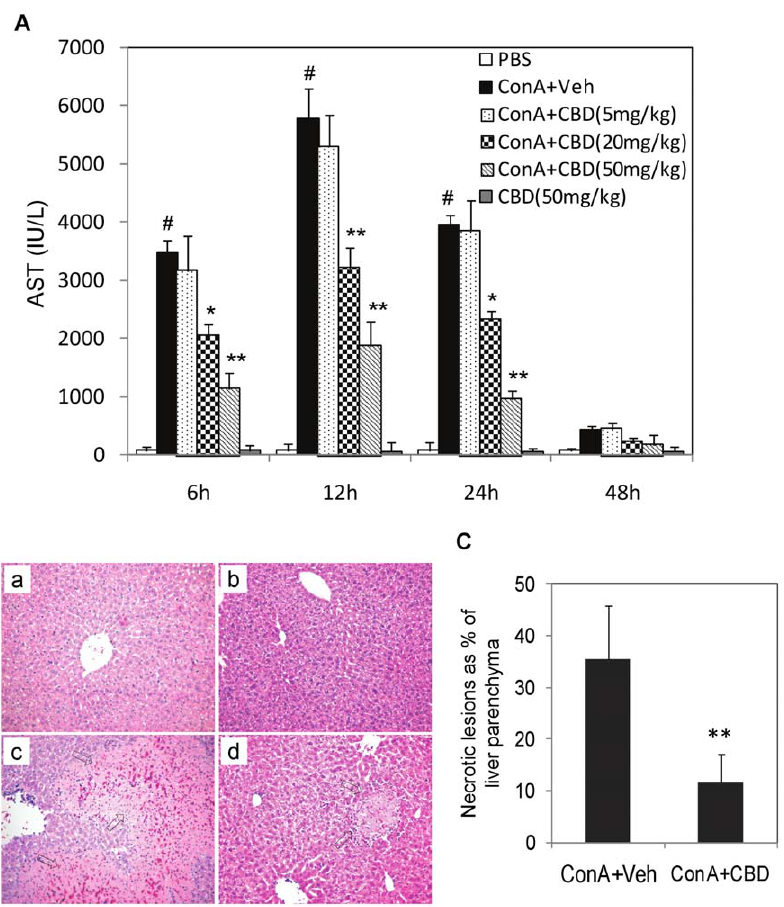
Figure 1. Cannabidiol (CBD) attenuates ConA-induced hepatitis in mice. WT mice (n=6) were injected with PBS (control), or ConA (12.5 mg/ kg bd.wt., i.v. ) to induce hepatitis. ConA injected mice were administered i.p. with vehicle or CBD at 5, 20 or 50 mg/kg bd.wt. CBD group received CBD alone at 50 mg/kg. A) Blood was collected at 6, 12, 24 and 48 h and serum aspartate transaminase (AST) was determined by spectrophotometric assay. Data represent mean 6 SEM from 6 individual mice. The changes in AST levels were analyzed by Student’s t -test ( # p , 0.01 compared to PBS; *p , 0.05, **p , 0.01 compared to ConA + veh). Histological analysis: B. Representative H&E stained liver sections obtained 24 h post ConA injection in WT mice (original magnification 6 100). a) Vehicle and b) CBD alone, show normal tissue morphology; c) ConA + veh shows large necrotic lesion induced by ConA (arrows); d) ConA + CBD (50 mg/kg bd.wt.) shows less necrosis (arrows) of liver parenchyma. C) Quantification of necrotic lesions as a percentage of liver parenchyma. Data are mean 6 SEM from 4 mice per treatment. At least five fields were analyzed per section from each liver sample. PBS and CBD controls did not show any necrotic lesions. Student’s t -test, **p , 0.01 compared to ConA.